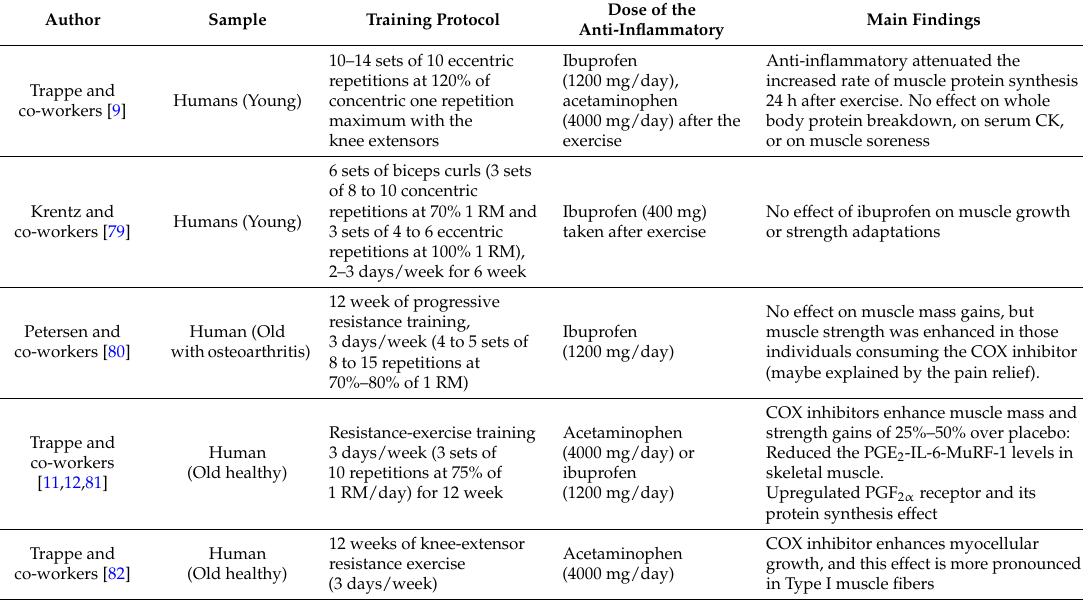
Summary of the human studies of PGs, skeletal muscle, and exercise responses and/or